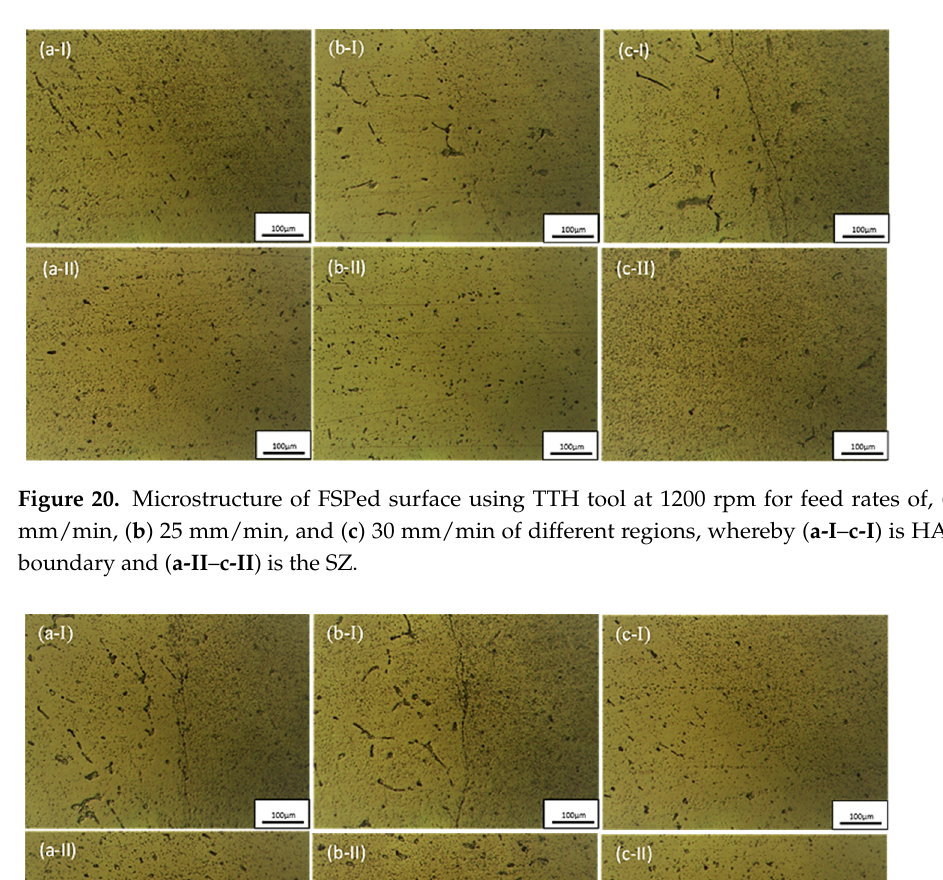
Figure 19. Microstructure of FSPed surface using TTH tool at 1150 rpm for feed rates of, ( a ) 20 mm/min, ( b ) 25 mm/min, and ( c ) 30 mm/min of different regions, whereby ( a-I – c-I ) is HAZ-SZ boundary and ( a-II – c-II ) is the SZ.